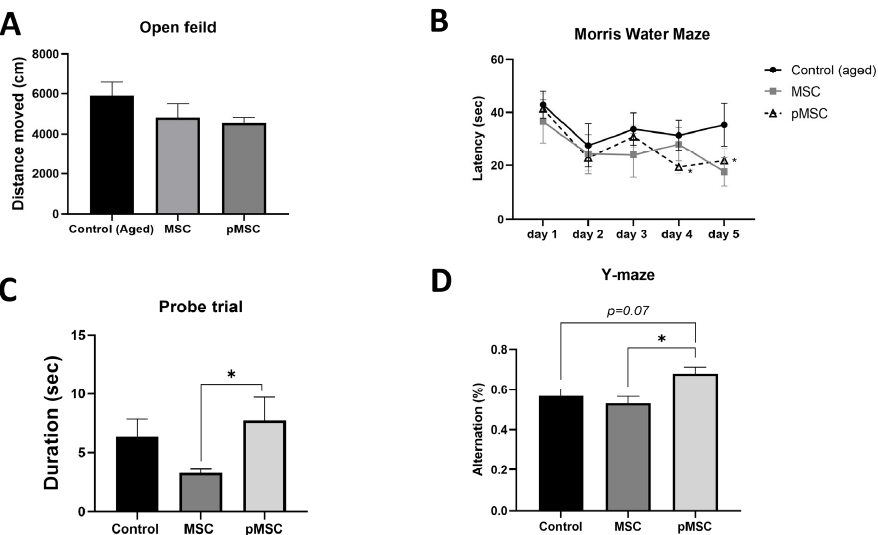
Figure 5. Systemic administration of polarized MSC improves cognitive function in aged mice. To assess the therapeutic potential of anti-inflammatory MSC, we administered 2*10 5 naïve (MSC) and polarized PACAP-treated MSC (pMSC) intravenously to 18-months aged mice. No significant dif- ferences were observed between the different groups in general locomotion activity, as assessed in